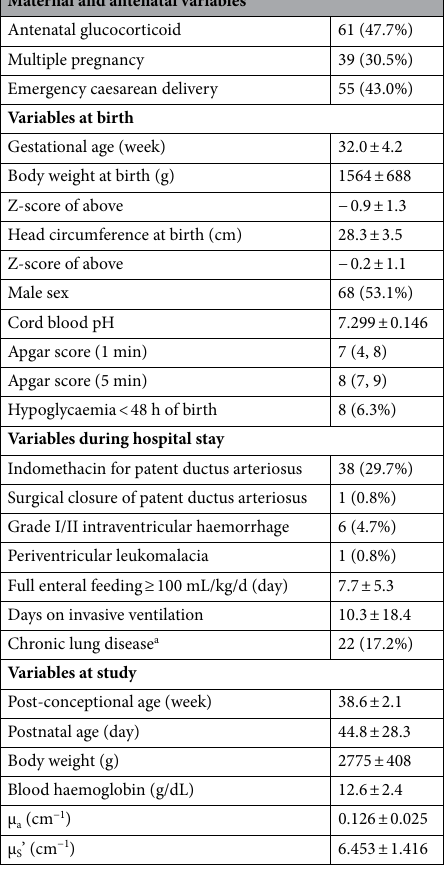
Table 1. Background characteristics of 128 infants within the study cohort. Values are number (%), mean ± standard deviation or median (lower/upper quartiles). µ a absorption coeffieicnt, µ s ’ reduced scattering coefficient. a Assessed at 36 weeks post-conceptional age (or on day 28 for those born later than 32 weeks